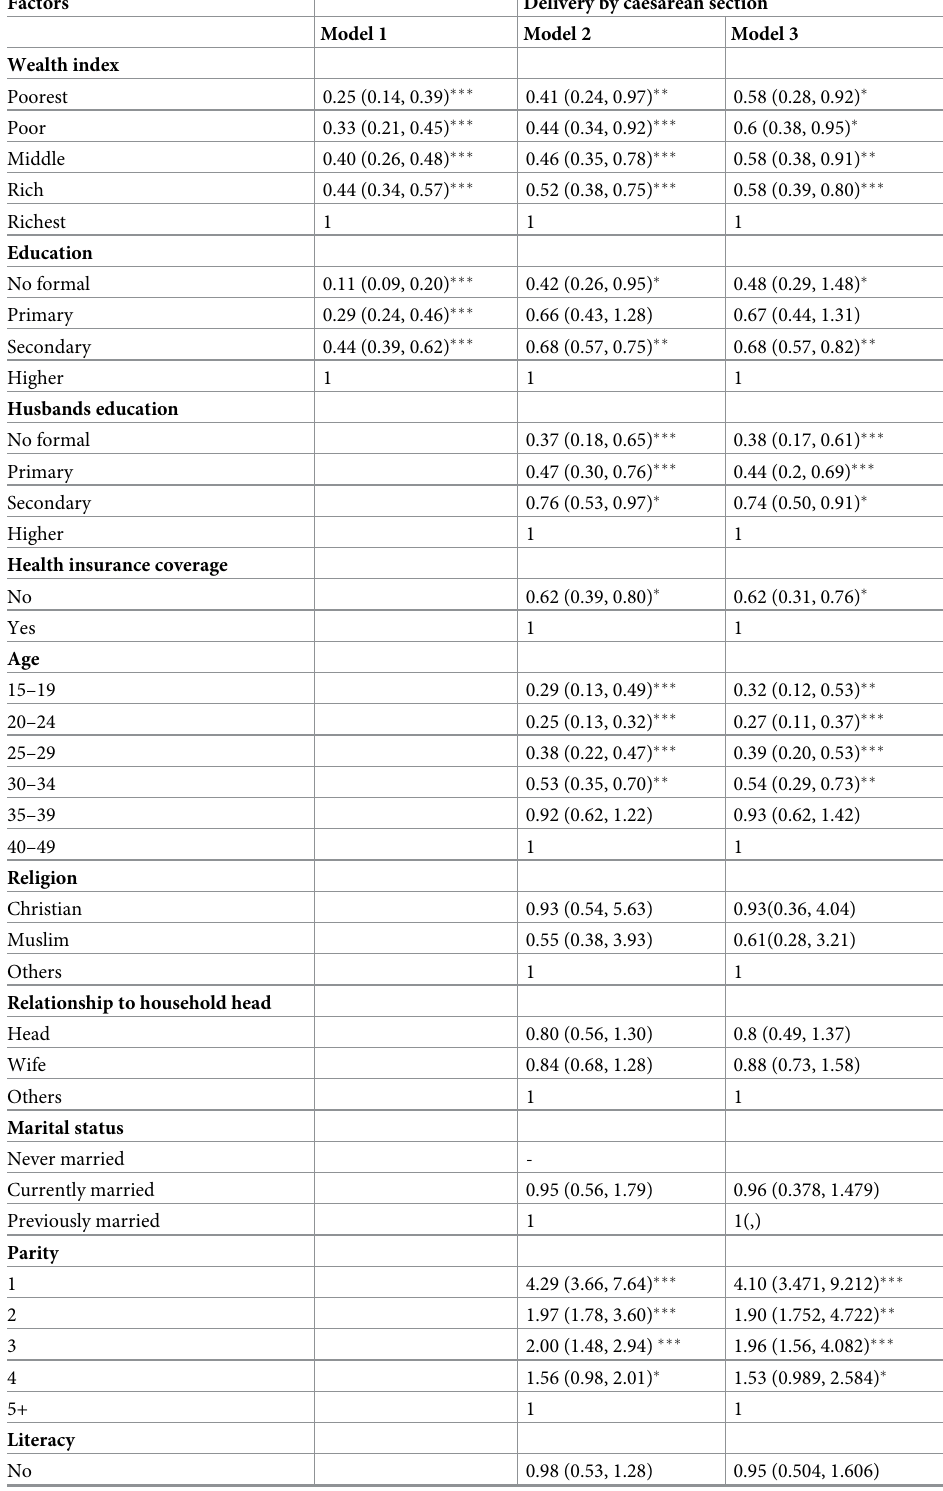
Table 4. Logistic models for delivery by caesarean